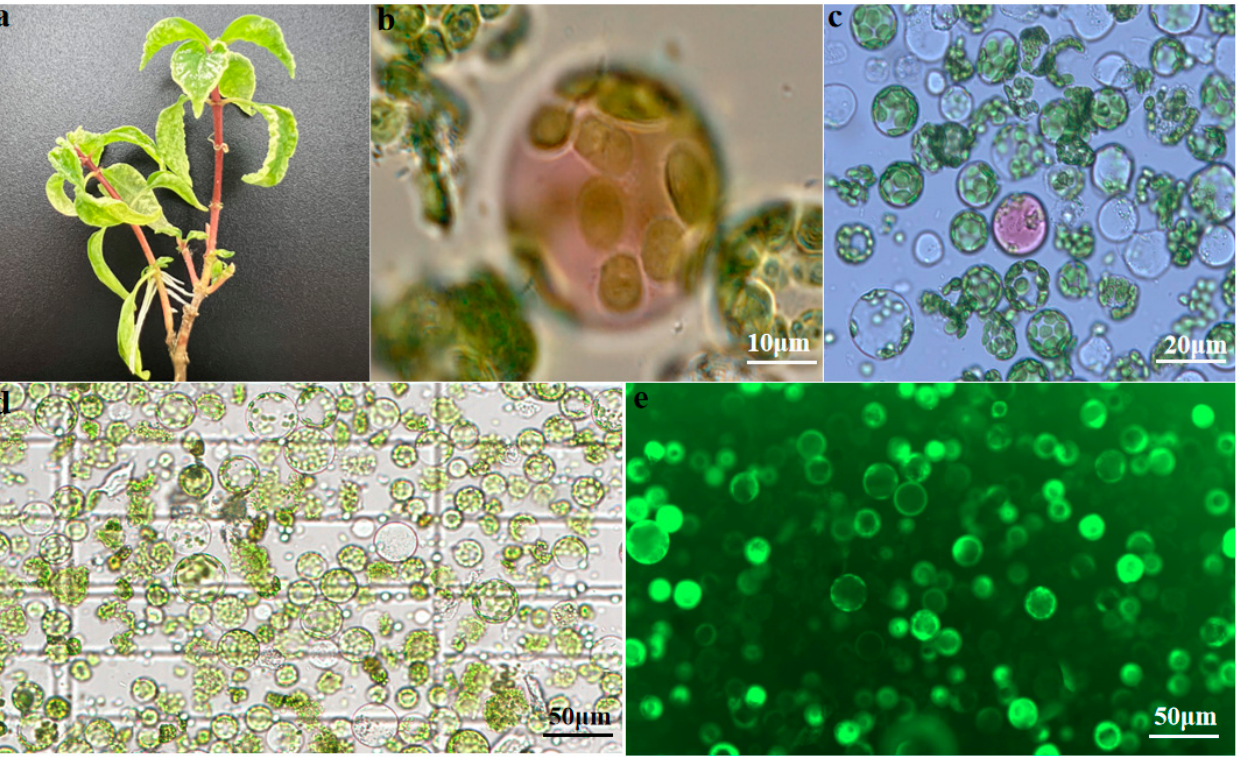
Figure 1. Isolation of protoplasts from leaves of U. rhynchophylla plantlets. ( a ) Initial material used for protoplast isolation. ( b ) Freshly isolated protoplasts, bar = 10 µm. ( c ) Freshly isolated protoplasts, bar = 20 µm. ( d ) The yield of U. rhynchophylla protoplasts was observed under a fluorescence microscope with ×10 objective, bar = 50 µm; bright field channel. ( e ) The viability of U. rhynchophylla protoplasts was observed under a fluorescence microscope with a × 10 objective. Protoplasts with green fluorescence were viable. Bar = 50 µm. GFP channel.